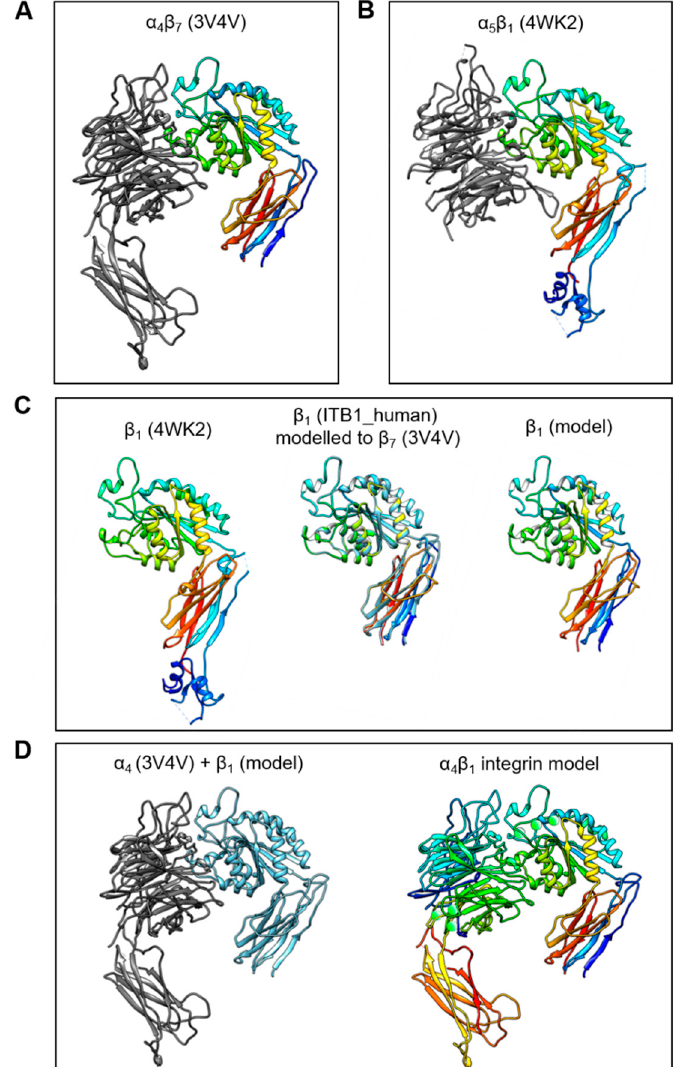
Figure 1. Generation of the integrin α 4 β 1 protein model. The process of generating a working integrin α 4 β 1 receptor protein model was as follows: ( A ) The α 4 β 7 resolved head domain model (PDB code 3V4V) and ( B ) the α 5 β 1 resolved head domain model (PDB code 4WK2) were utilized as templates for α 4 and β 1 subunits, respectively. ( C ) The β 1 subunit (4WK2) was mapped using the ITB1_human peptide sequence and the β 7 subunit (3V4V) as references, to generate a β 1 subunit model in active conformation. ( D ) The α 4 (3V4V) and newly generated β 1 model subunits (left image) were compiled into a single α 4 β 1 integrin model (right image) with H-bonds and metal ions (green spheres).